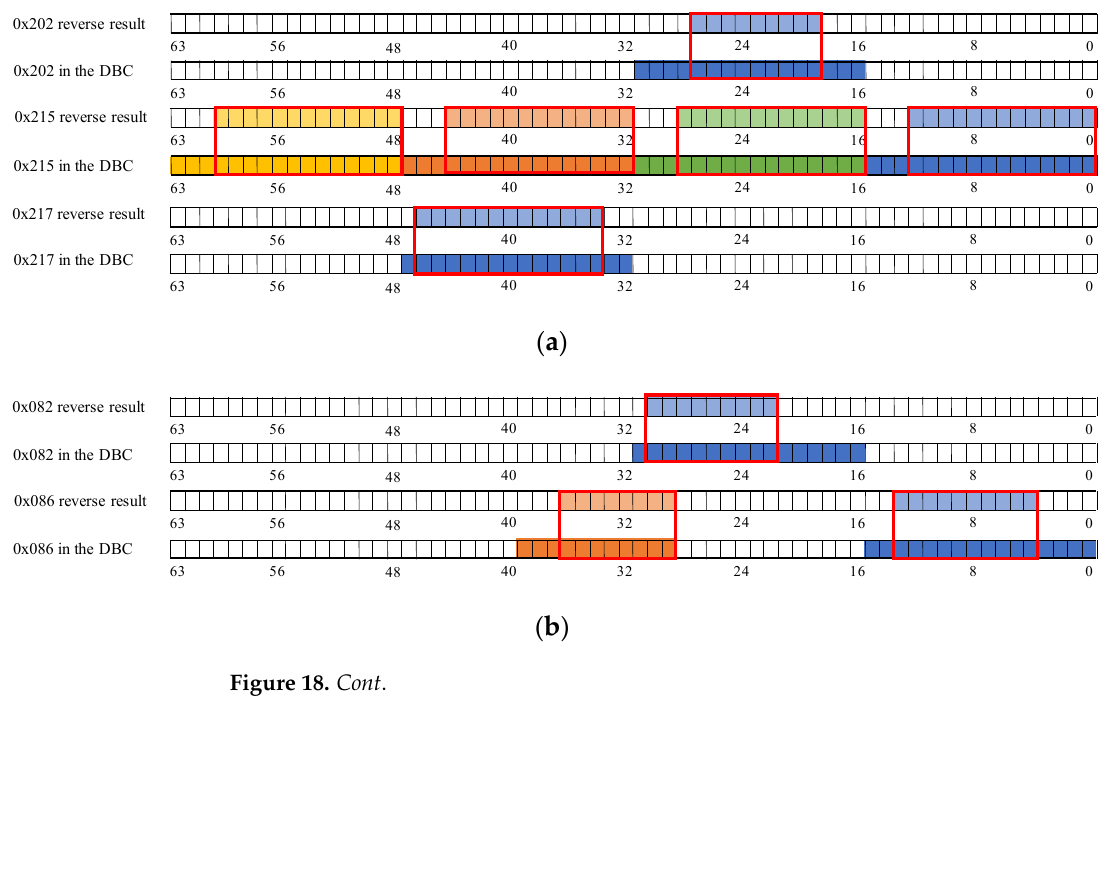
Table 6. Message filtering accuracy results for vehicle behavior.